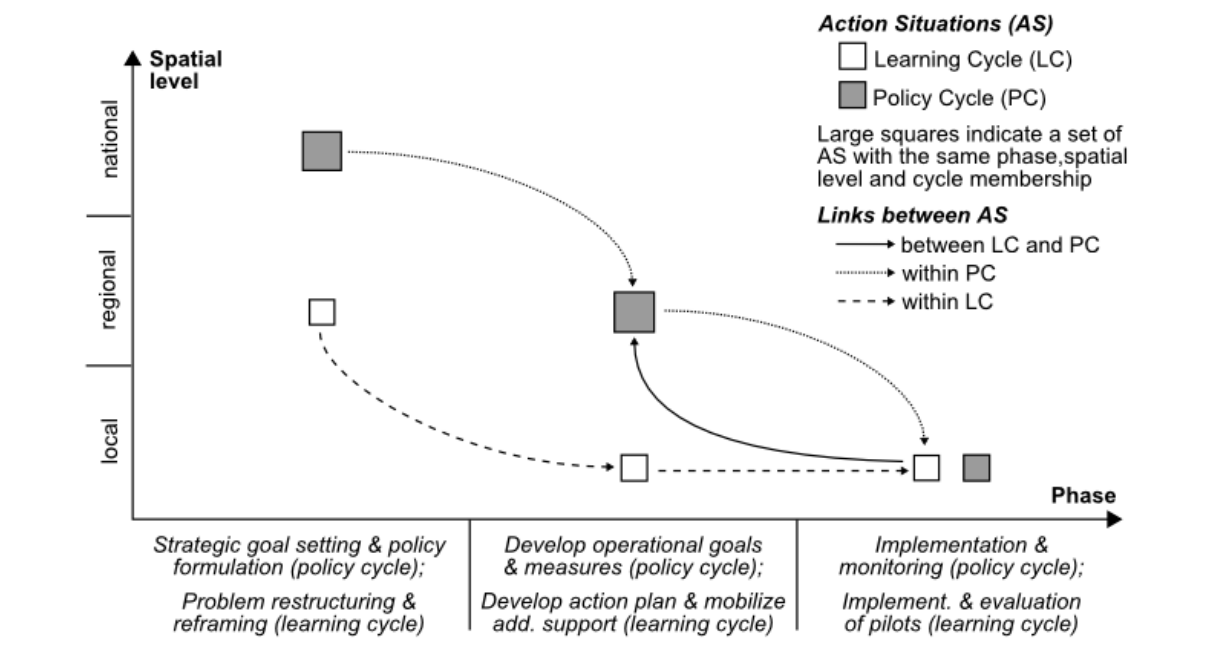
Fig. 2 . Representation of policy and learning processes as sequences or networks of connected action situations (AS). The y-axis represents the spatial level at which an AS is located. The x-axis represents the phases of policy and learning cycles, respectively. To simplify the graphical representation of cases with many ASs and connections between them, ASs in the same phase and the same spatial level are aggregated. The different size of the boxes reflects the number of ASs represented. Furthermore, the seven phases distinguished for the policy cycle in the management and transition framework (MTF; Table A1 in Appendix 1) are aggregated to three major